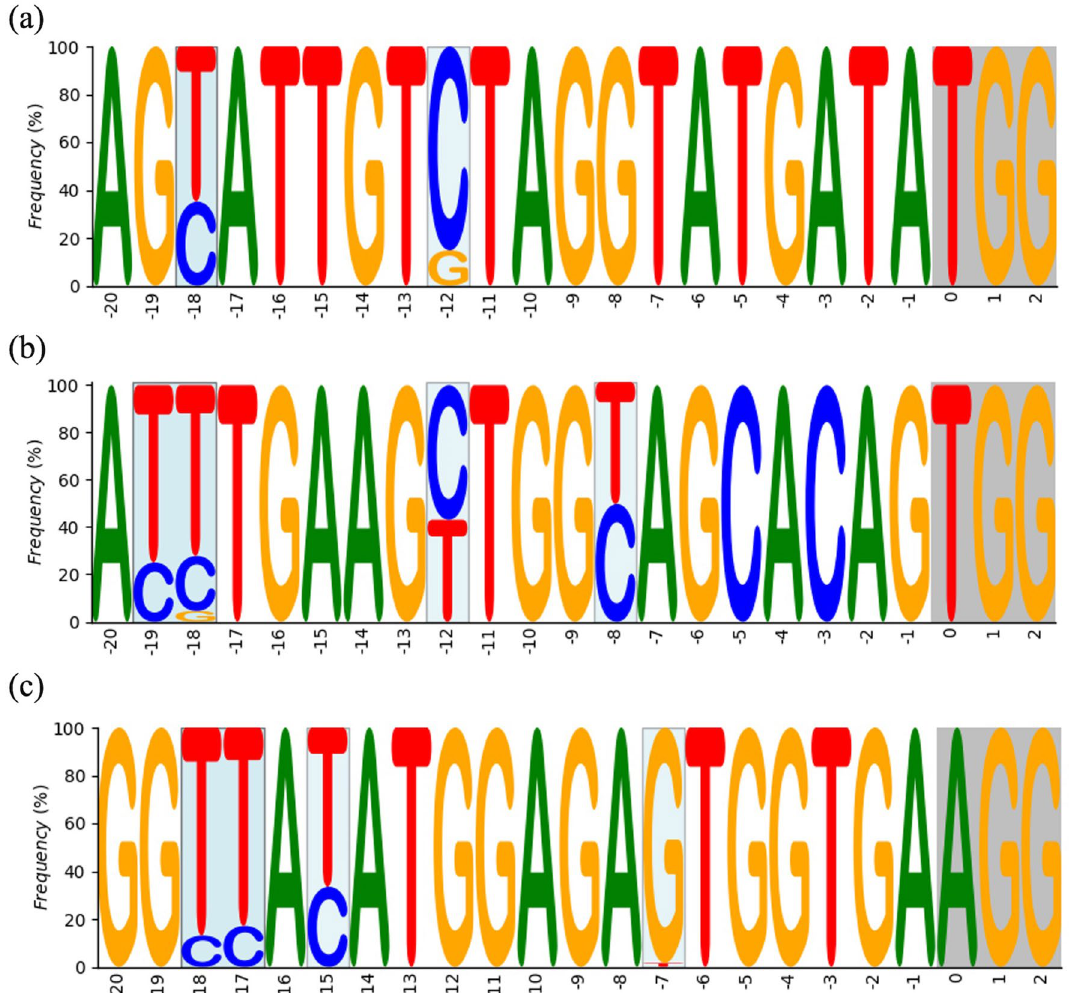
Figure 2. Logo Fig. of the deep sequencing analysis of on-target sites following Target-AID induction in tomato. Representation of the pattern of mutation induced by Target-AID with the corresponding sgRNA sequence in ( a ) Sl DDB1 , ( b ) Sl DET1 and ( c ) Sl CYC-B . Light blue background represents substitution areas, grey background represents PAM sequences. Numbers under the sequence represent the position of nucleotide from the PAM sequence, zero starting from the nucleotide N of NGG PAM